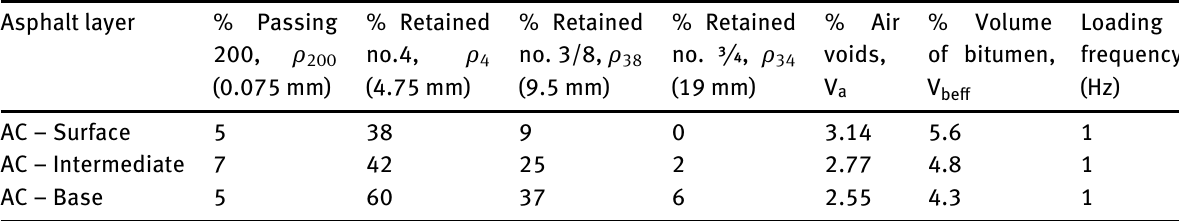
Table 4: Asphalt layer properties of Korean Railway Research Institute’s track [13]. Asphalt layer